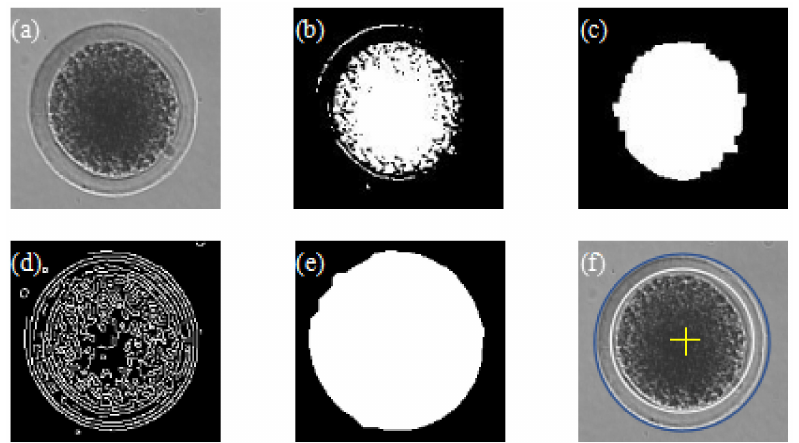
Figure 2. Oocyte detection. ( a ) Original image. ( b ) Binary image of the oocyte. ( c ) Image after morphological closing and opening. ( d ) Canny edge detection image. ( e ) Binary image after image closing and opening. ( f ) Oocyte detection